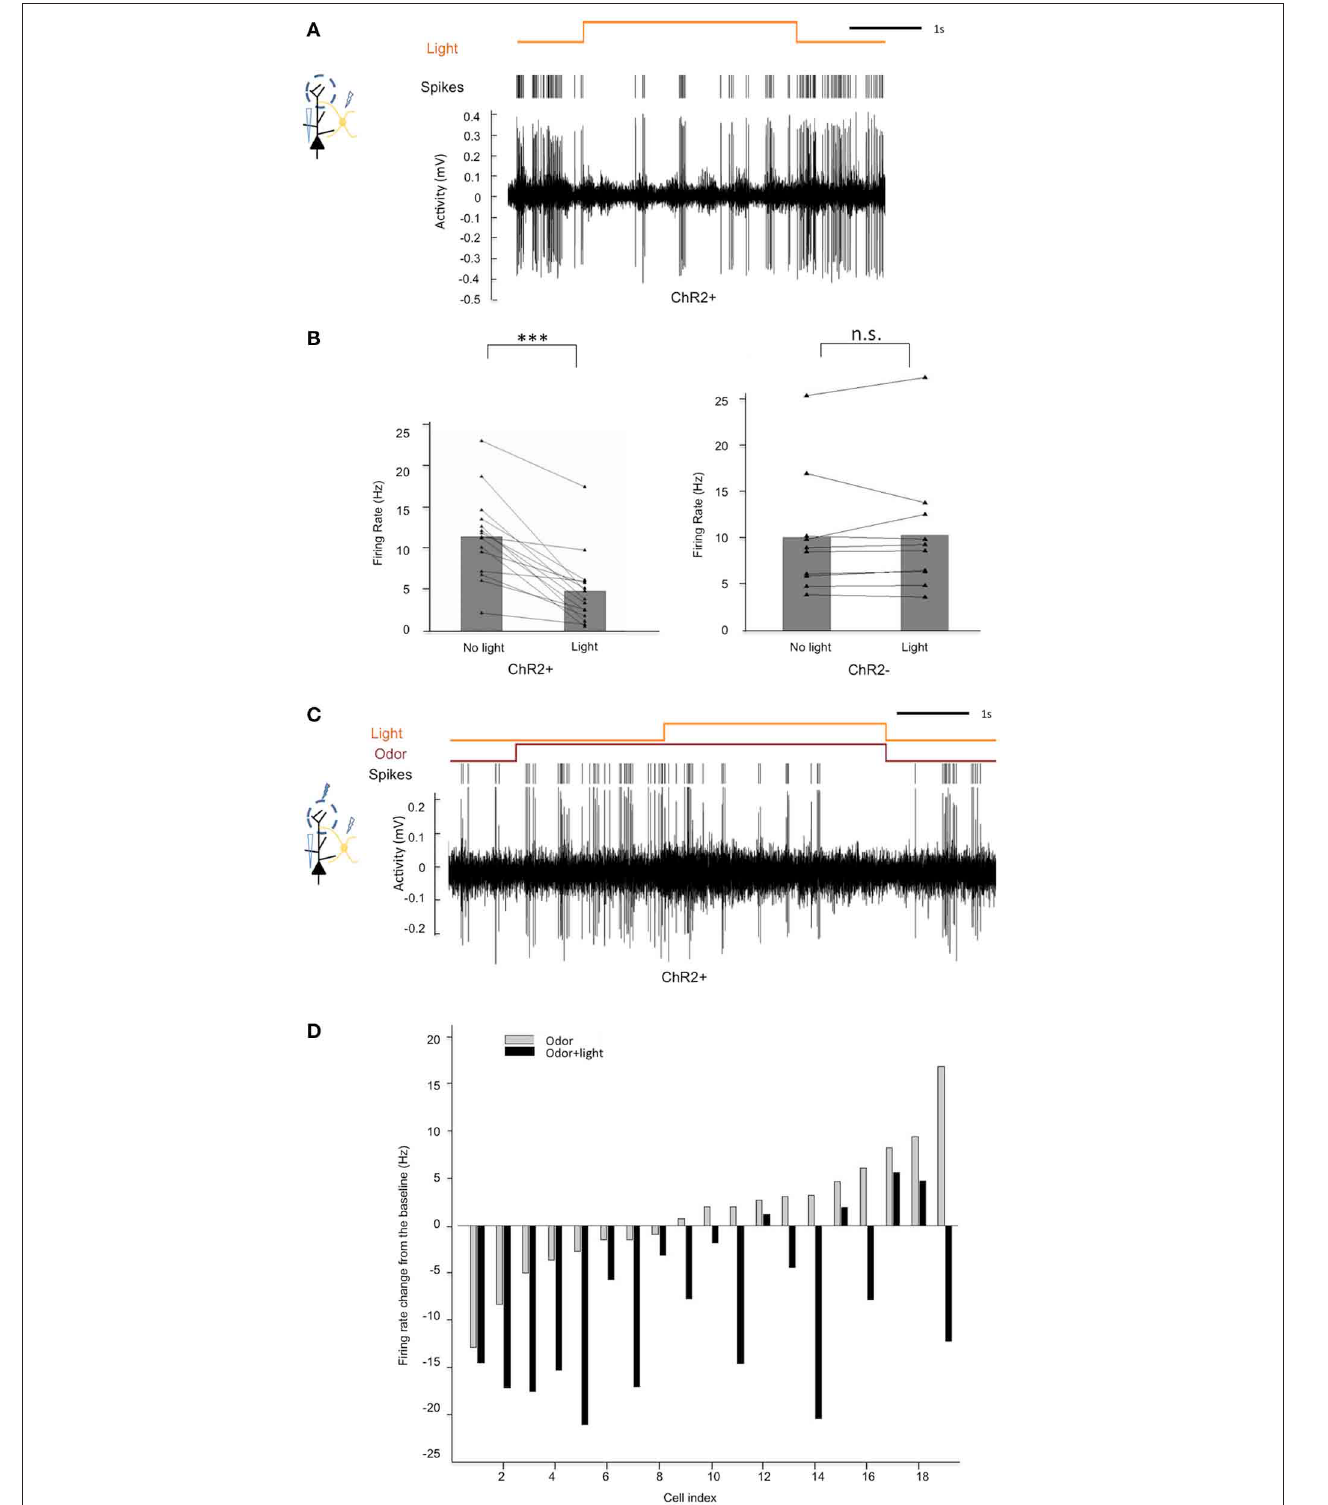
FIGURE 6 | Activation of CRH + EPL interneurons inhibits spontaneous and odor-evoked mitral cell firing in vivo . (A) A representative trace showing the inhibition of spontaneous mitral cell firing by light activation of CRH + EPL interneurons during extracellular single unit recording in a